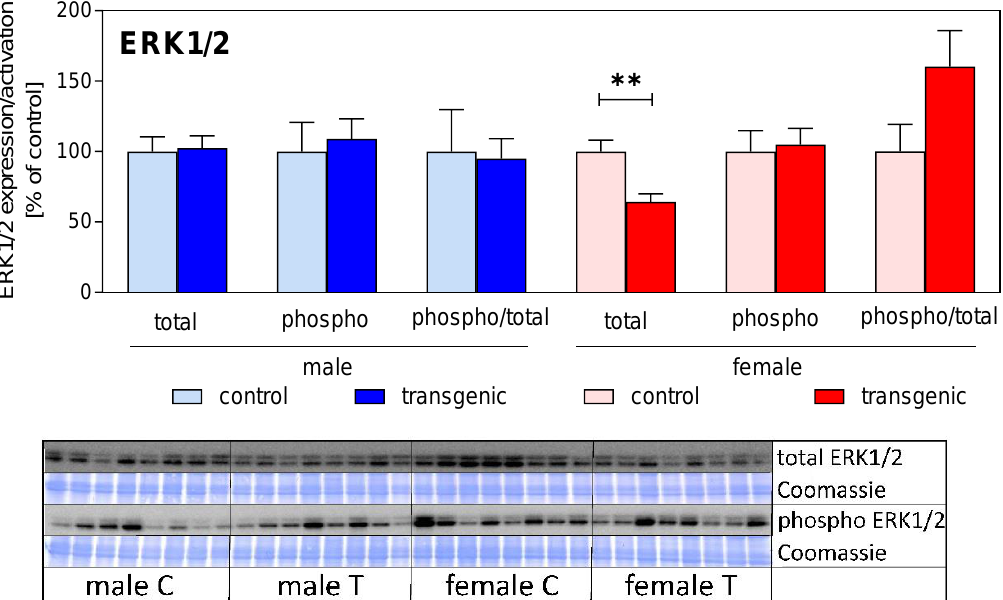
Figure 5. Protein expression (total), phosphorylation (phospho), and specific activity (phospo / total) of protein kinase B (AKT; upper panel) and extracellular regulated kinase (ERK1 / 2, lower panel) in muscle extracts from male (blue) and female (red) IGFBP-2 transgenic mice and non-transgenic littermates (DU6P / C57BL / 6). Analysis of signal transduction was performed by Western immunoblotting as described in Section 2 (mean ± SEM; age: 7 weeks; n = 8; #: p < 0.1; *: p < 0.05; **: p < 0.01). The results from Western immunoblotting are provided both for AKT and ERK1 / 2. Coomassie blue staining was performed in order to demonstrate equal loading and protein transfer to the carrier membranes, respectively.